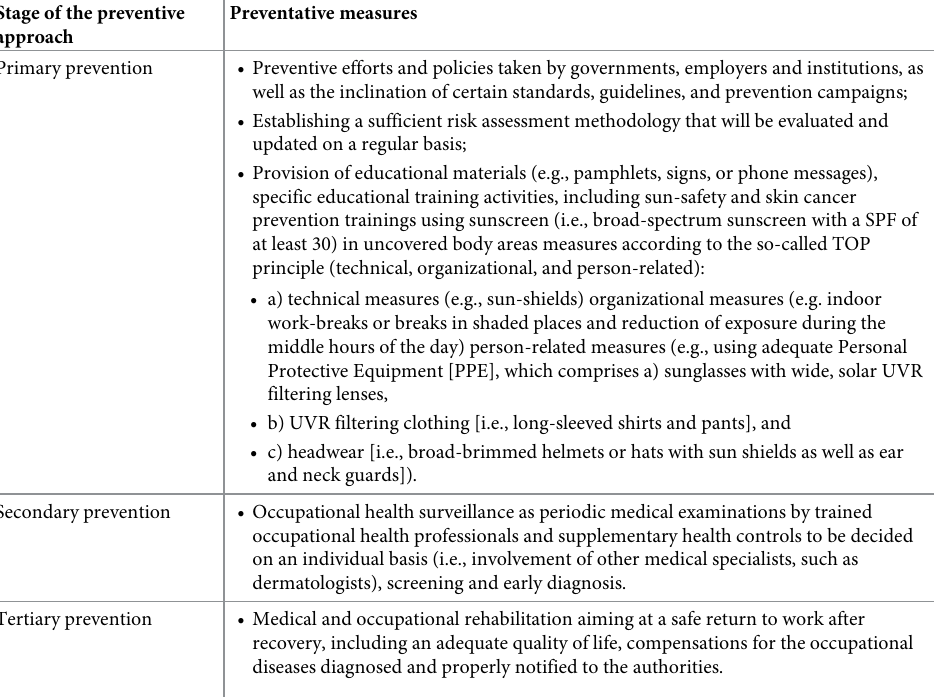
Table 1. Measures of primary prevention (i.e., any preventive action aimed at reducing the incidence of cancer in humans), secondary prevention (i.e., preventative action that leads to the detection of precancerous conditions or cancers at an early stage), and tertiary prevention (i.e., actions that take place when the adverse effects are already manifested, including e.g., medical and occupational rehabilitation)